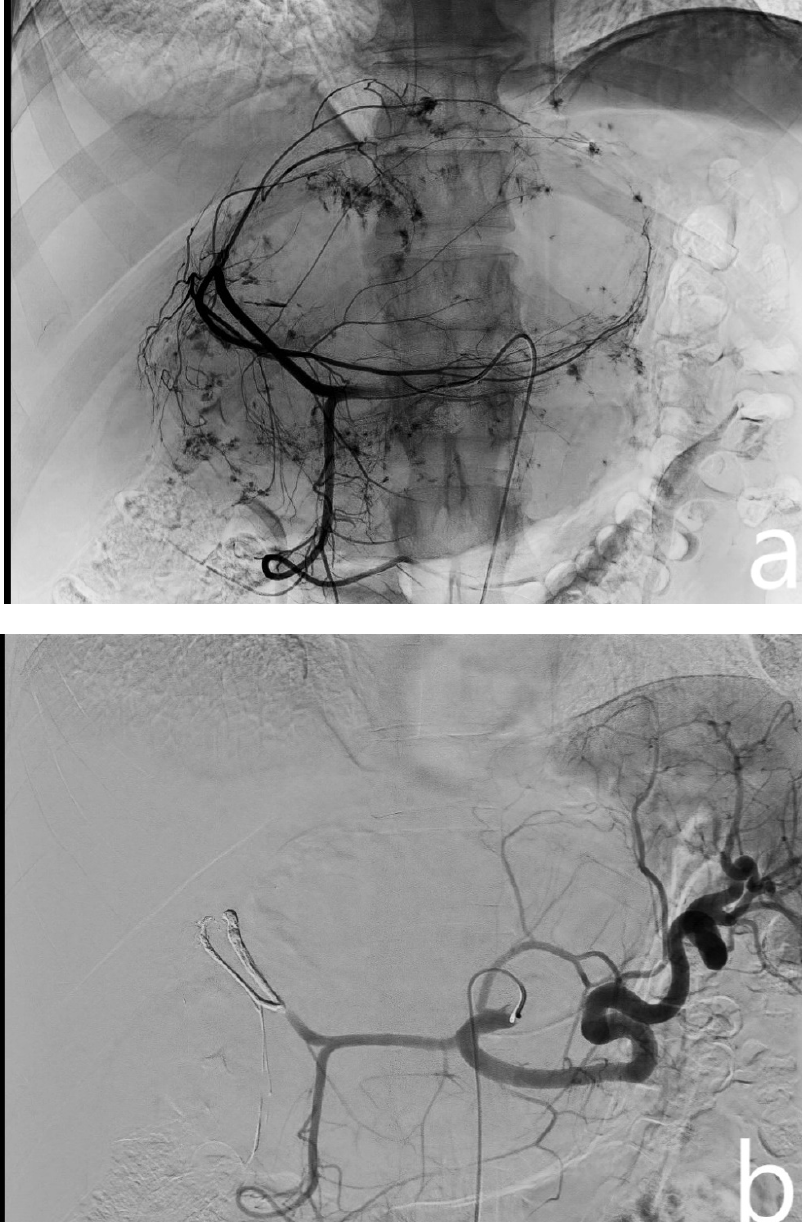
Figure 1. On preoperative CT ( a ), a giant hemangioma of the right liver lobe is identified, with evidence of vascular afference from the right phrenic artery (arrow). On angiography, after identification and emboliza- tion of the right hepatic artery ( b ), right phrenic artery is selectively catheterized and embolized with micro- particles ( c ).